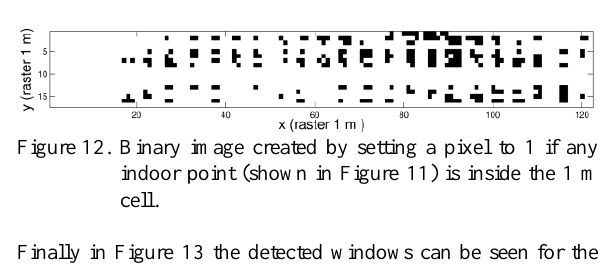
Figure 11. Indoor points derived from the points shown in Figure 10 and the threshold shown in Figure 4.